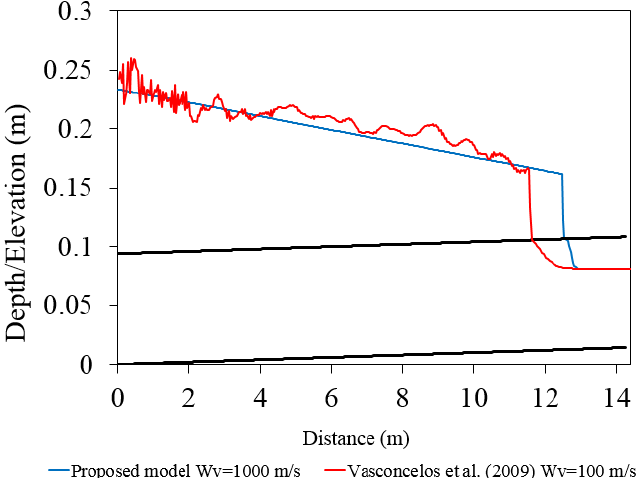
Figure 9. Hydraulic grade lines at the time of 6 s.